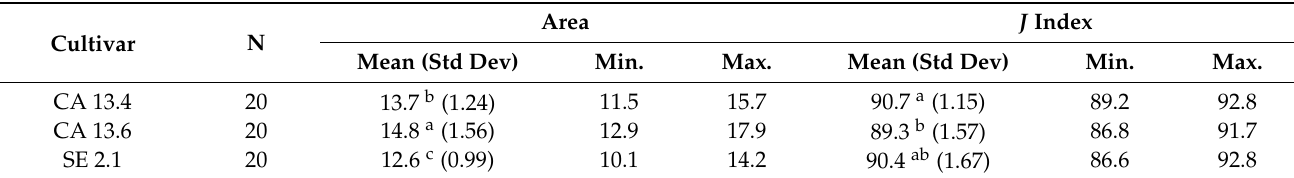
Table 4. Values of area and J index in the three cultivars of the Sylvestris group. Superscript letters indicate the results of Scheff é test: the mean values marked with the same letter in the superindex of each column do not differ significantly at p < 0.05. N is the number of seeds analyzed.